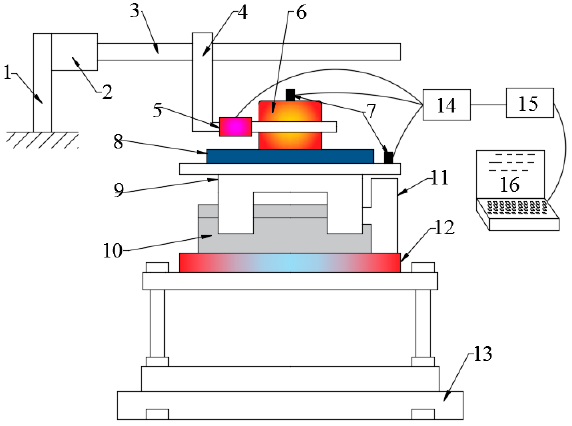
Figure 1. Schematic diagram of setup. 1 . Driving arm holder; 2 . linear motor; 3 . screw rod; 4 . driving arm; 5 . load cell; 6 . upper specimen; 7 . accelerometer; 8 . bottom specimen; 9 . sliding table; 10 . slide rail;